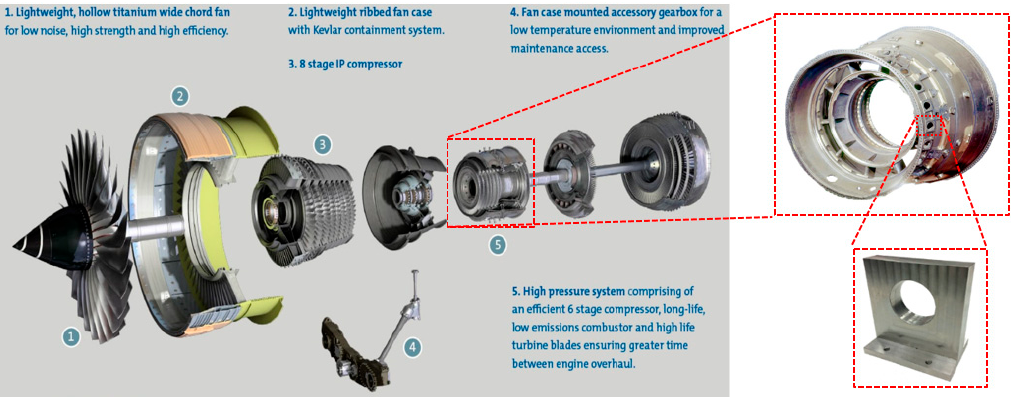
Figure 4. The boss-hole location on a breakdown of a Trent 700 engine.